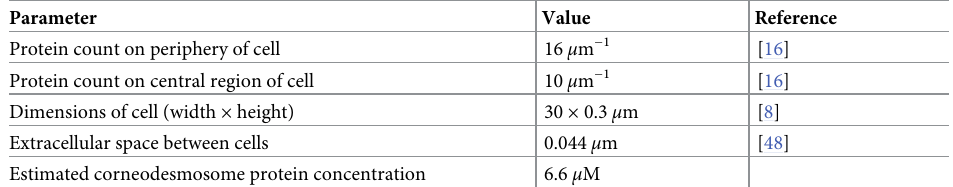
Table 3. Parameters used to determine the concentration of corneodesmosome